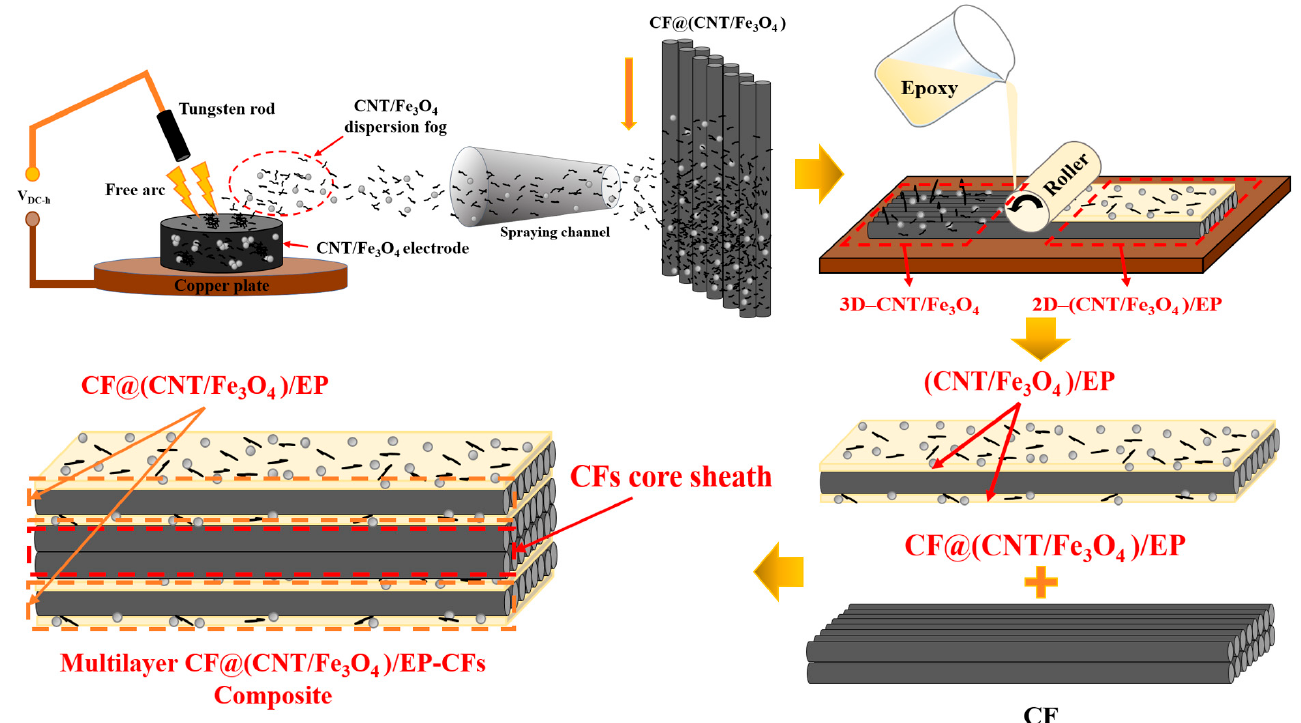
Figure 1. Schematic diagram of CF@(CNT/Fe 3 O 4 )/EP composite preparation process. As is shown in Figure 2a, the left side is pure CFs, and the middle and right side are the CFs sprayed with CNT/Fe 3 O 4 dispersion fog. It can be clearly seen that pure CFs has a light color and luster, but the CFs sprayed with CNT/Fe 3 O 4 dispersion fog appears darker color. This is because the adsorption of CNTs and Fe 3 O 4 on the CFs surface and changes the diffuse reflection of CFs surface. Figure 2b shows that pure CFs has a smooth surface without any substance. Figure 2c,d show the attachment of CNT/Fe 3 O 4 when CFs moving speed is 0.01 m/s and 0.02 m/s, respectively. The faster CFs moving speed, the less CNT/Fe 3 O 4 is deposited, and the lighter color is appeared on the macroscopic (Figure 2a, right). At the same time, CNTs and Fe 3 O 4 have high dispersion degree and without obvi-